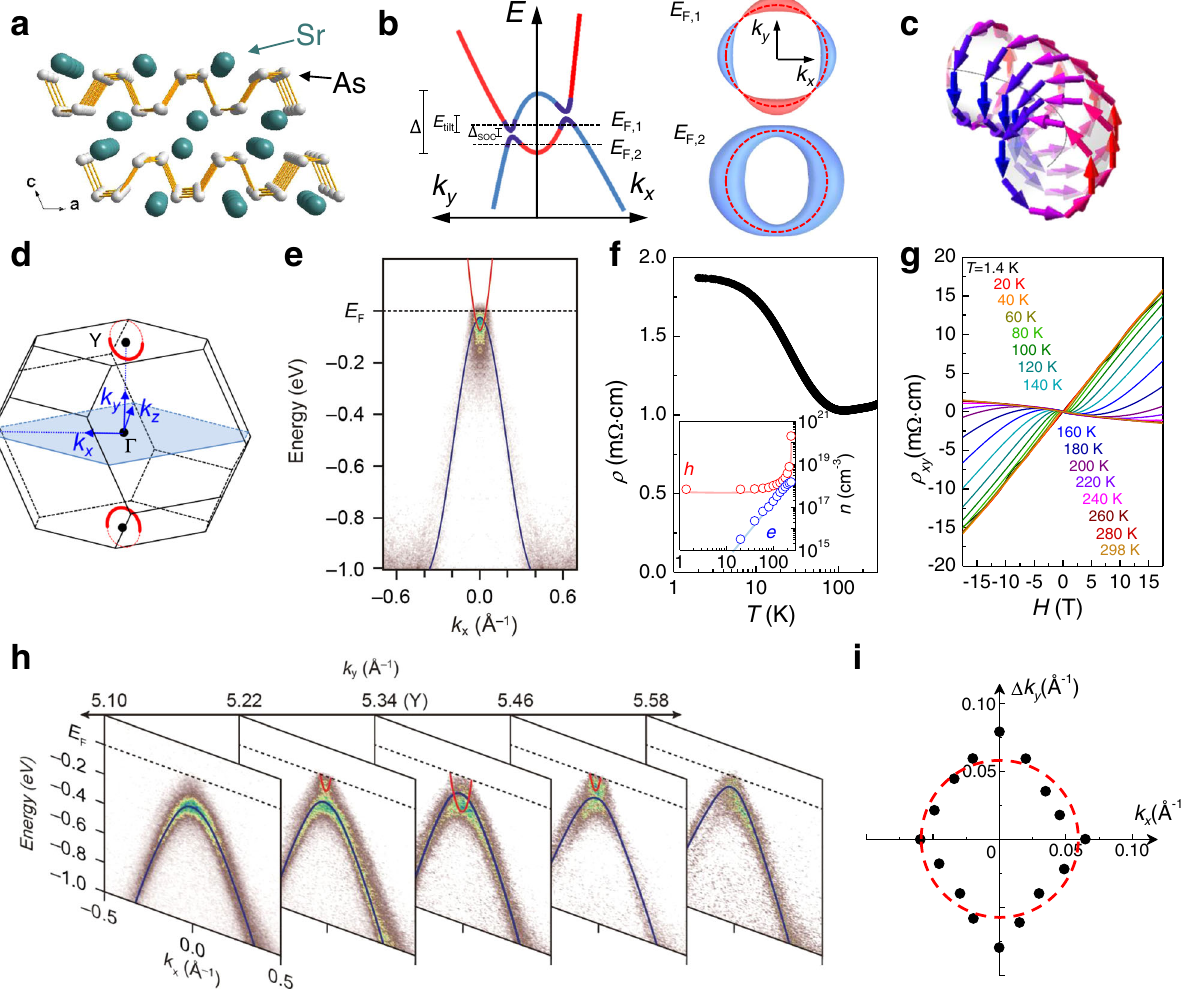
Fig. 1 | Crystal and electronic structures of a nodal-line semimetal SrAs 3 . a The crystalstructureofSrAs 3. b Theschematicbandcrossingforasymmetricnodal-line states with a tilted energy dispersion ( E tilt ), a fi nite spin – orbit-coupling gap ( Δ SOC ) andabandoverlapenergy( Δ ).ThecorrespondingFermisurfacesatdifferentFermi levels ( E F ) are shown in the right, a crescent-type for E F,1 and a torus-type for E F,2 . c The smoke-ring-type pseudospin texture imprinted on the Fermi surface. d The Brillouin zone of SrAs 3 with a single nodal ring (red circle) centered at the Y point. e TheARPESspectraofSrAs 3 takenattheYpointalong k x withthephotonenergyof